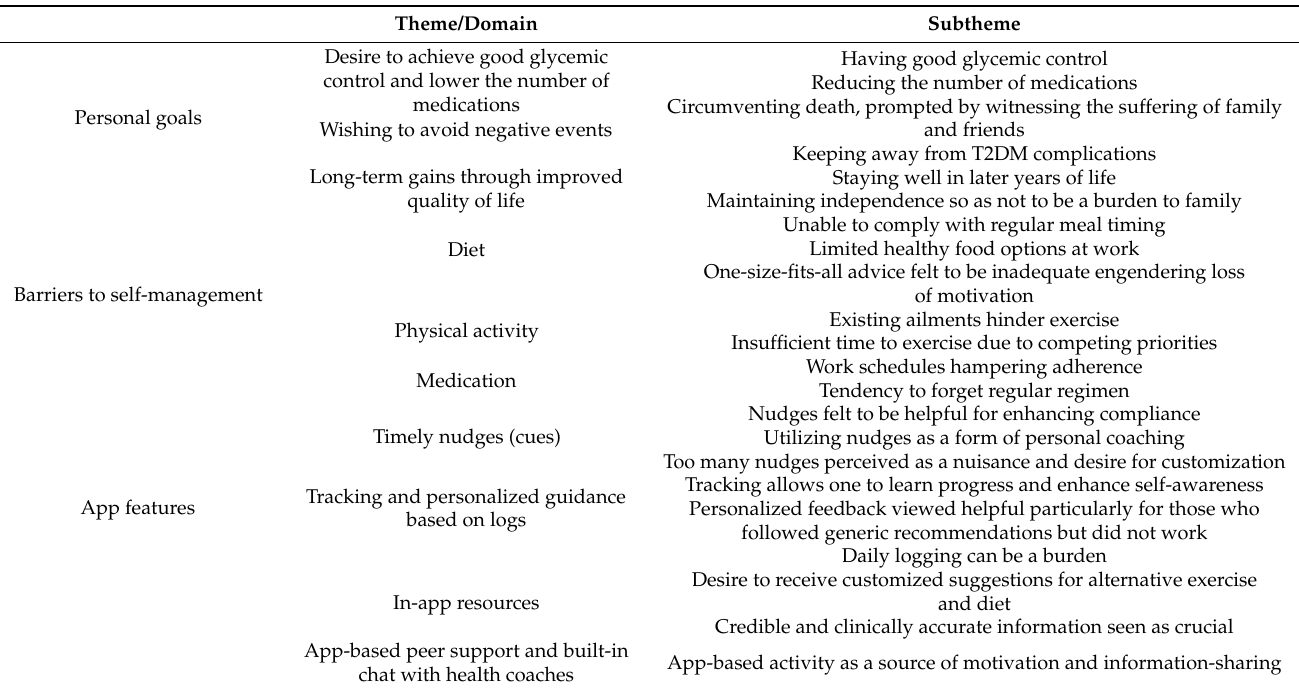
Table 2. Summary of themes and